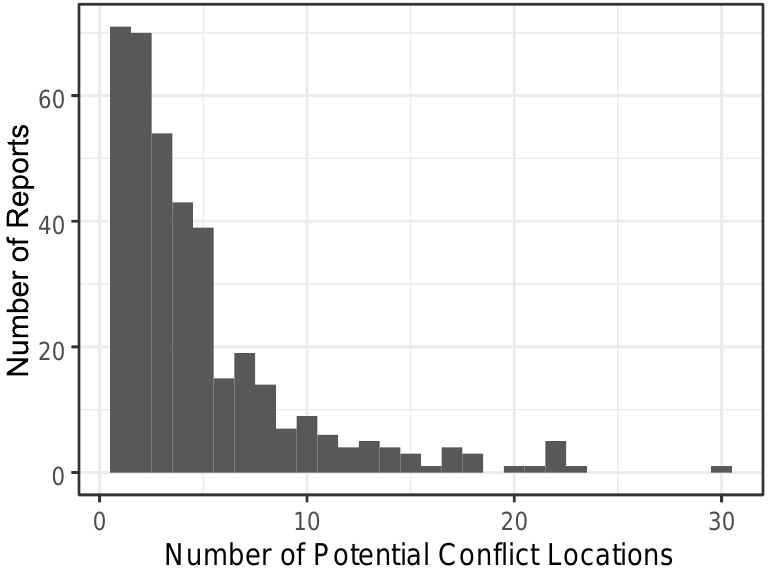
Fig A1.2 : Histogram of the number of potential conflict locations for all reports (n=380). Many reported conflicts had multiple potential locations, given that spatial information was not explicit, but rather included information on nearby village and water